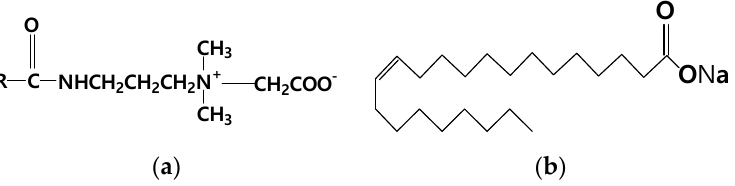
Figure 2. Molecular structures of VES components: ( a ) amido betaine; ( b ) sodium mesoporous acid.